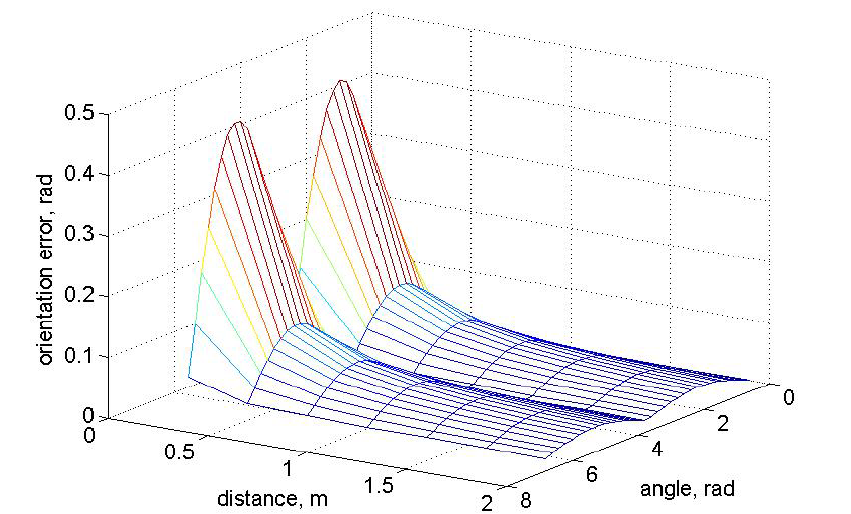
Figure 8. Orientation error angle as a function of distance between sensors and orientation angle for a fixed Cartesian